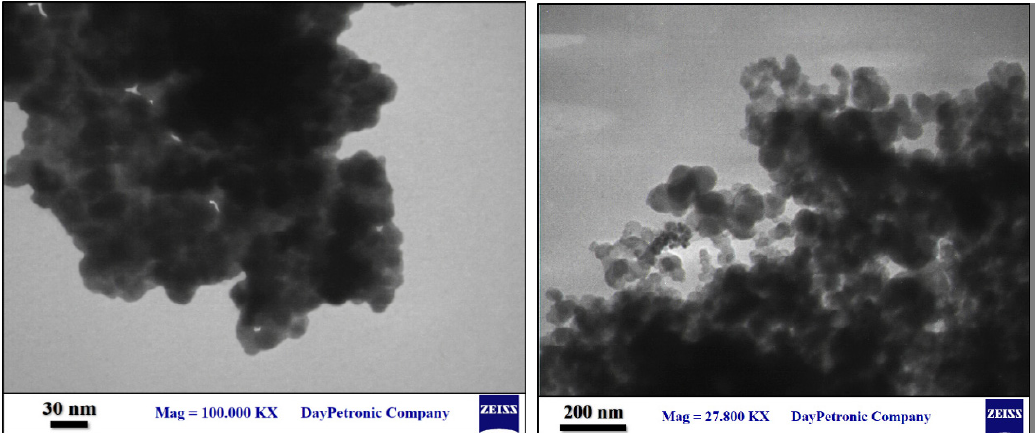
Fig. 4. TEM images of pectin/ γ -Fe